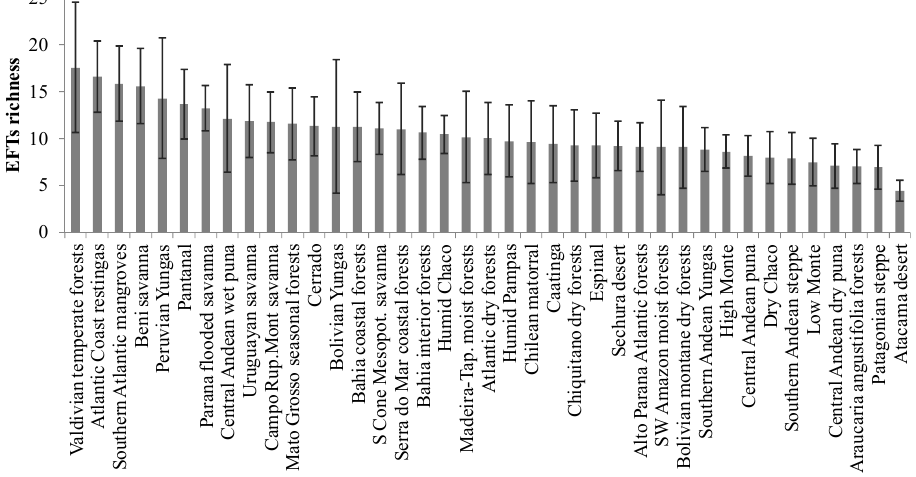
Figure 3. Mean EFT richness across the different ecoregions of South America. Error bars indicate the spatial standard